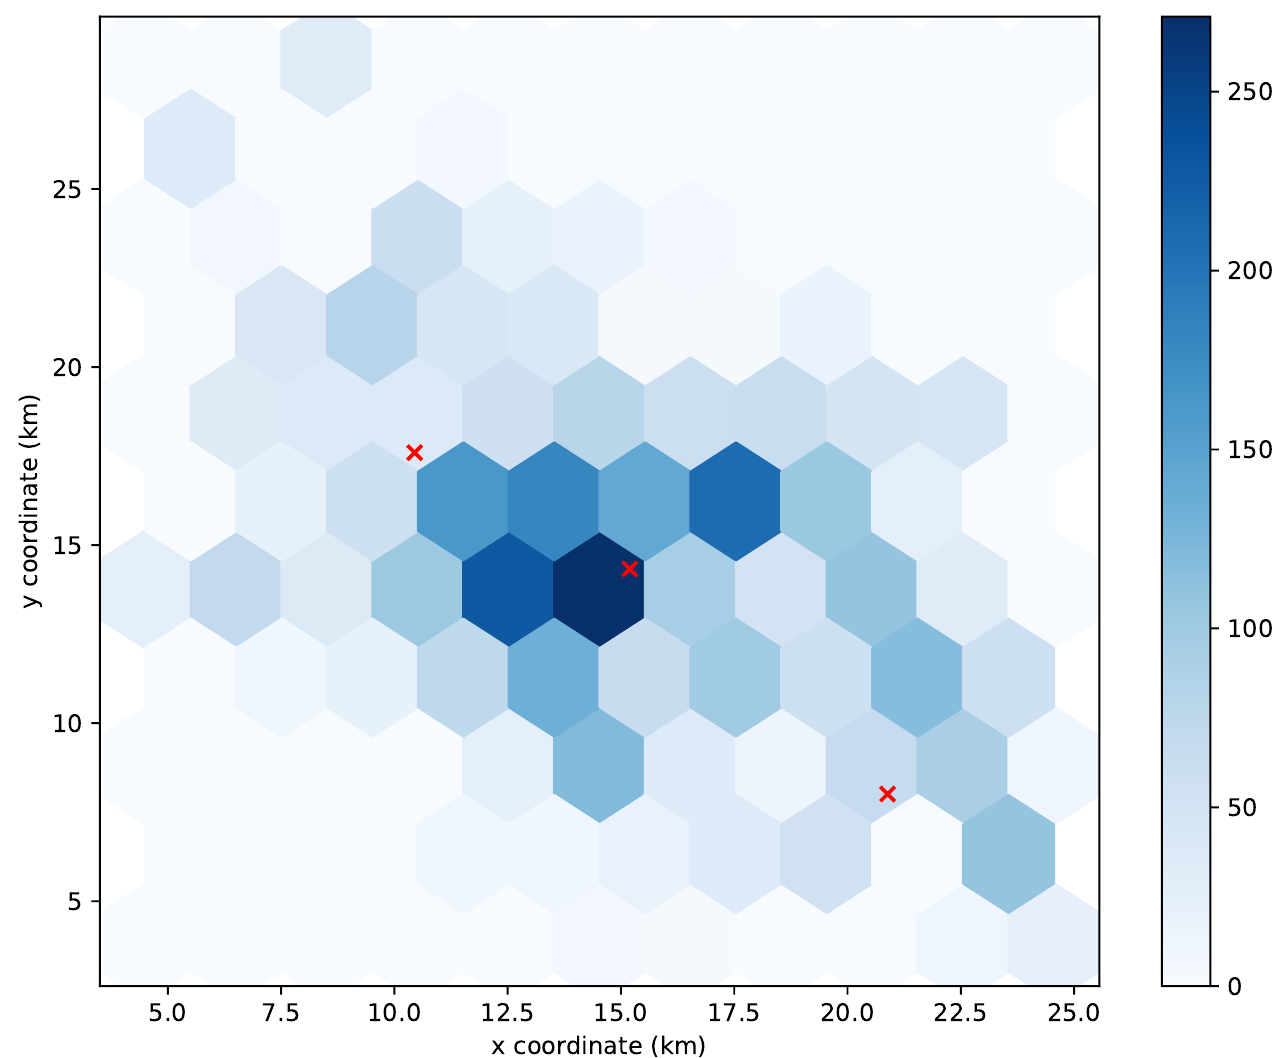
Figure 7. Distribution of 4112 UEs in the 3000th time slot of the simulation. The red crosses mark the location where 3 UPFs are allocated using the K-means